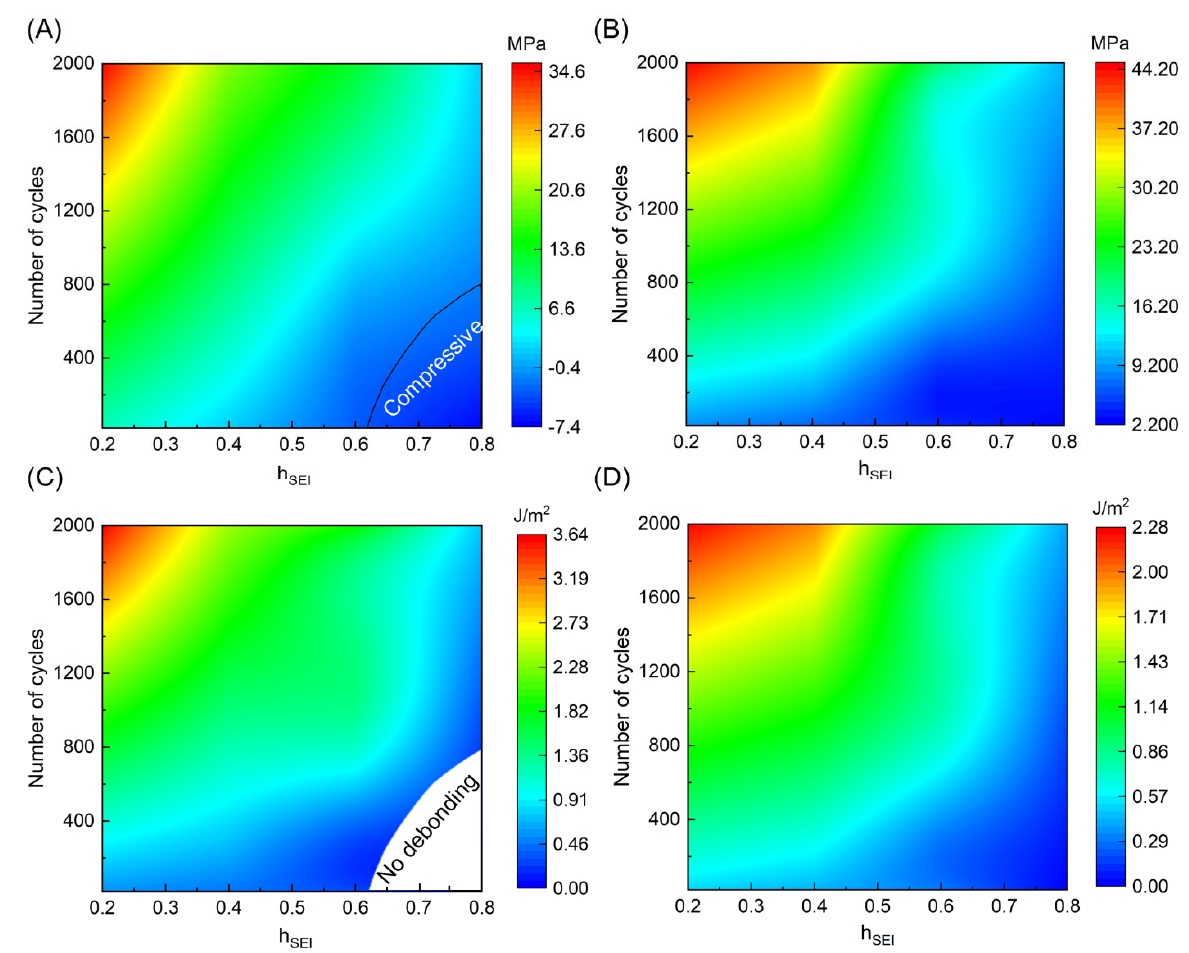
Figure 8. Contour plots of radial stress and debonding energy release rate G d as a function of cycle number and h SEI . Radial stress inside the ( A ) inorganic and ( B ) organic SEI layers. Debonding energy release rate G d inside the ( C ) inorganic and ( D ) organic SEI layers. In ( C ), the white area indicates no debonding onset, due to the compressive stresses.